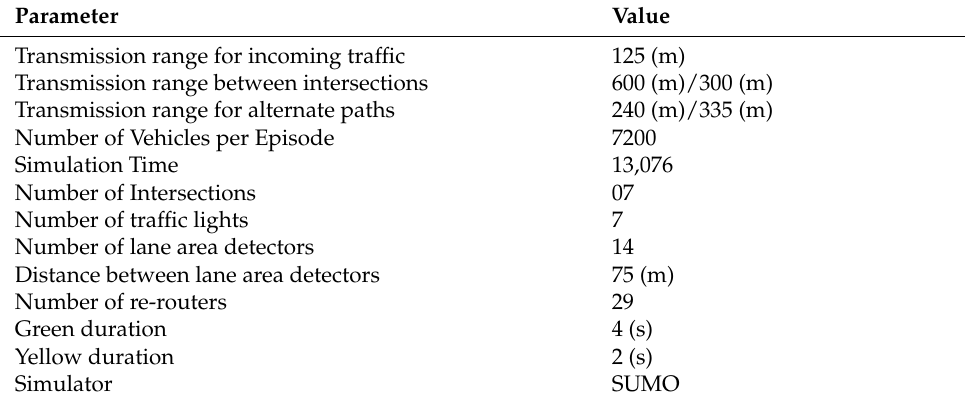
Table 1. Simulation